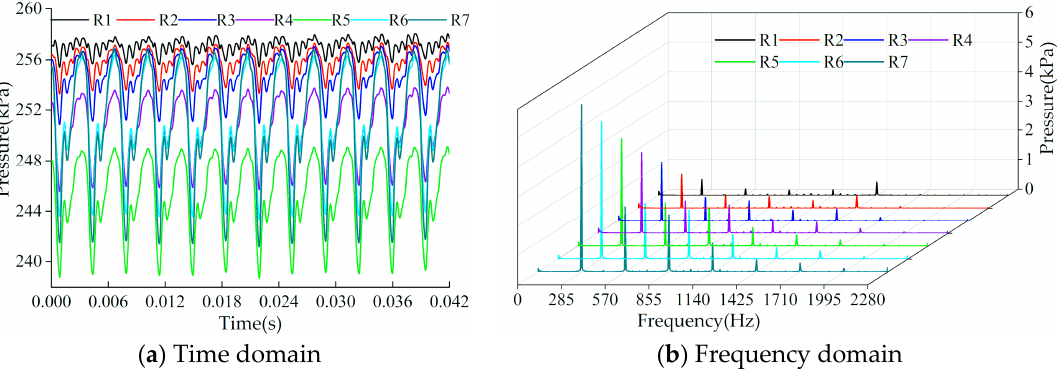
Figure 21. The time and frequency domain diagrams of pressure fluctuation for monitoring points at the middle streamline of a return guide vane channel.